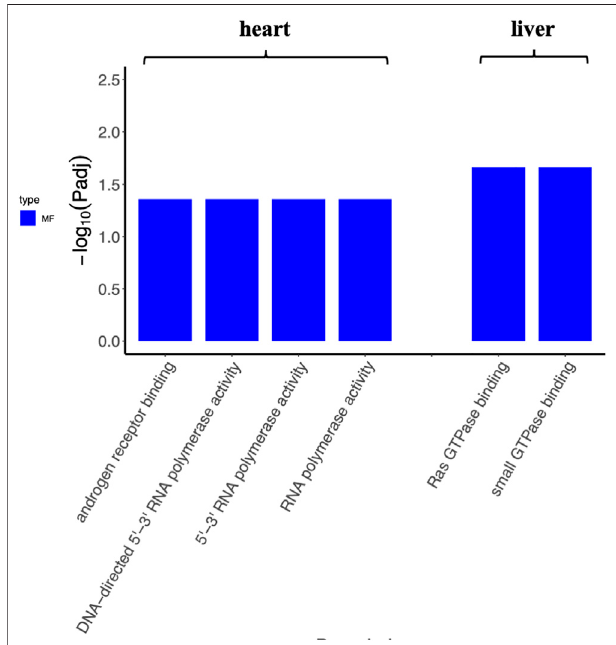
FIGURE 5 | The enriched GO terms of tissues (heart and liver) from the intragastric administration group. No GO term is enriched for the spleen, lung, and